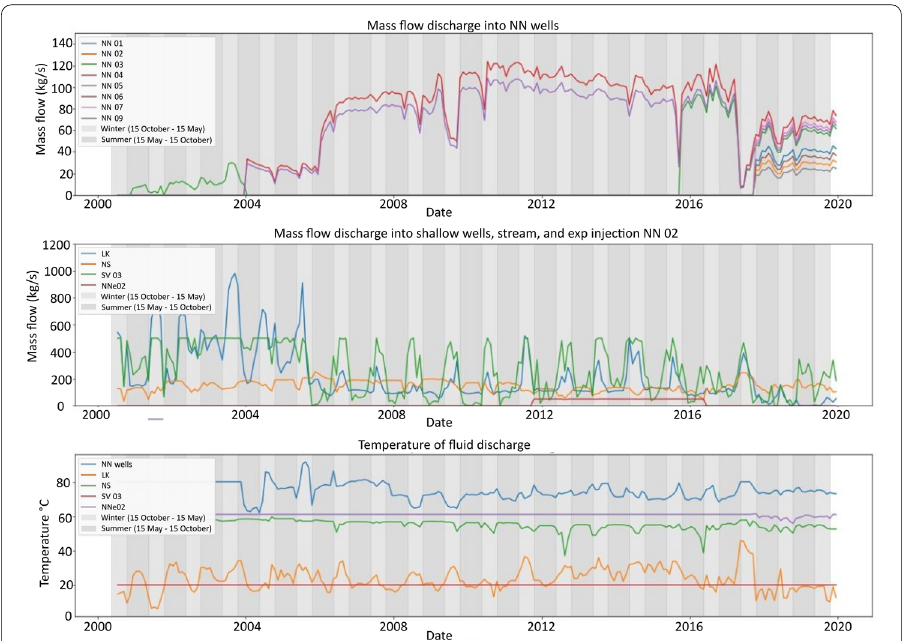
Fig. 6 Total injection rates and temperature of injected water during the simulation time. Dark shades of grey are the winter season and light shades are summer season. NNe02, shown in the middle plot, is an experimental test on